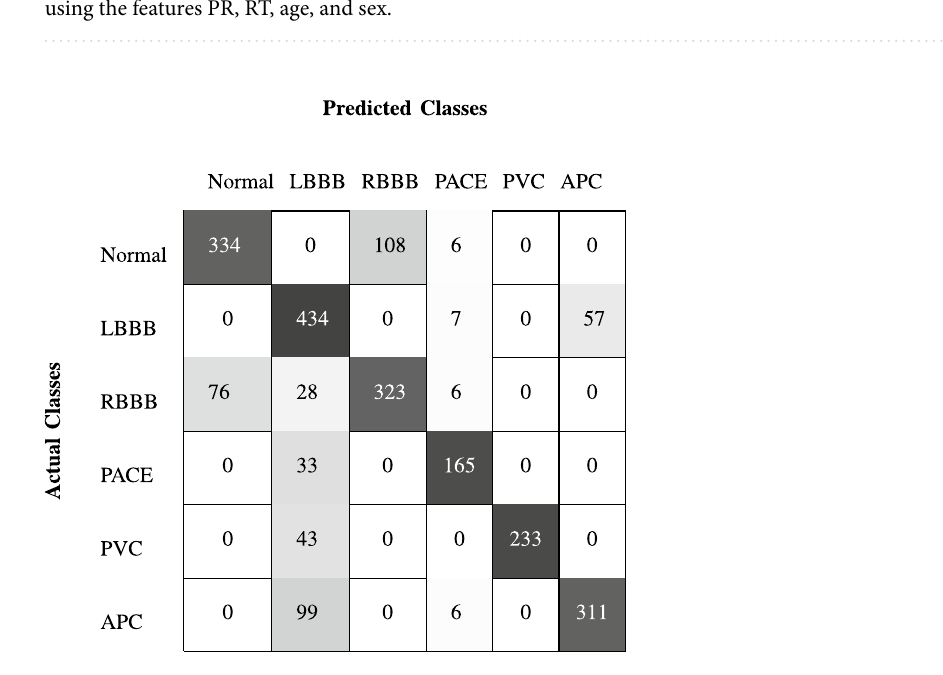
Table 5. Confusion matrix for MIT-BIH database using MLP